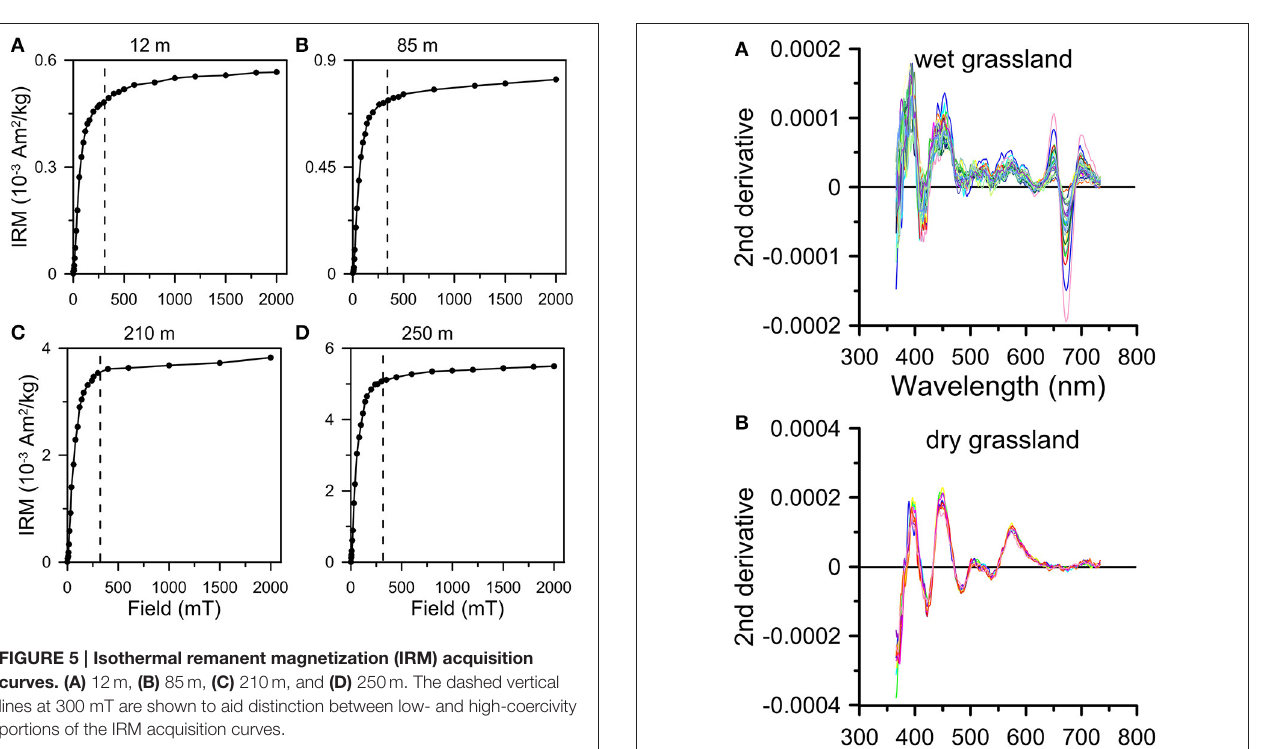
FIGURE 6 | Second derivative spectra of typical samples. (A) wet grassland samples, and (B) dry grassland samples.